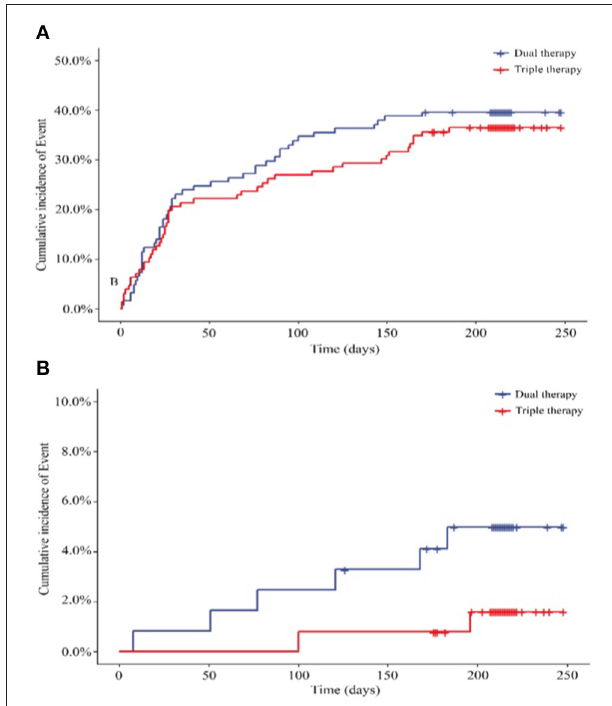
FIGURE 3 | (A) Primary outcome for the incidence of total bleeding in PPS ( N = 247) (HR, 0.889; 95% CI, 0.593 to 1.332; P = 0.5684); (B) Secondary outcome for the incidence of major bleeding (HR, 0.313; 95% CI, 0.063 to 1.552; P = 0.1550). HR, hazard ratio. Dual therapy: ticagrelor therapy group; triple therapy: clopidogrel plus aspirin group.